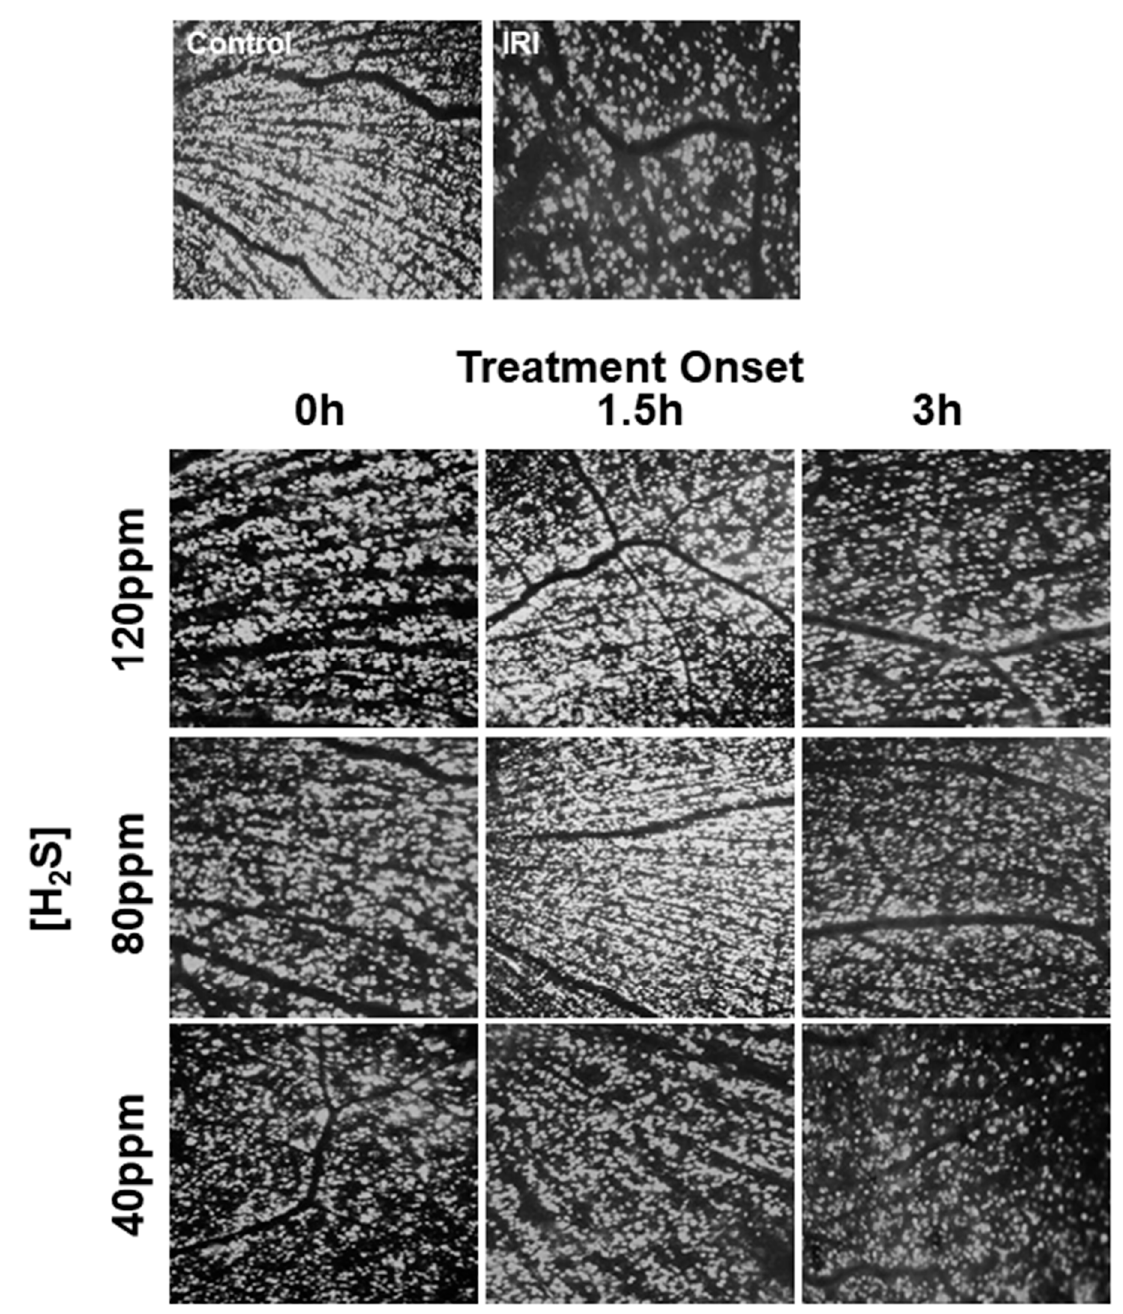
Figure 2. Time- and dose-dependent influence of H 2 S inhalation on vital retinal ganglion cells after ischemia–reperfusion injury (IRI). Representative flat mount images ( n = 8) of fluorogold-labeled retinal ganglion cells 7 days after IRI and immediate (0 h) and delayed (i.e., 1.5 and 3 h) H 2 S inhalation (40, 80 and 120 ppm).